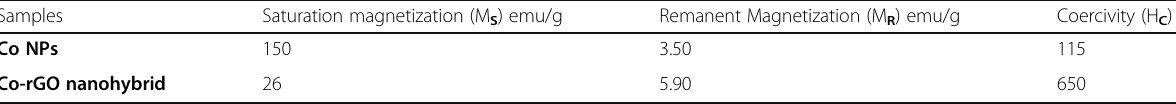
Table 1 Observed results from the M-H curve of Co NPs and Co-rGO nanohybrid